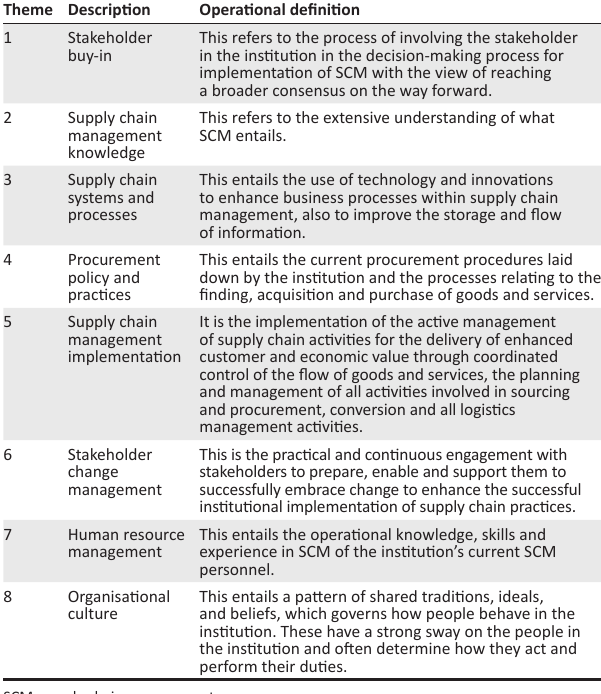
TABLE 3: Themes and operational